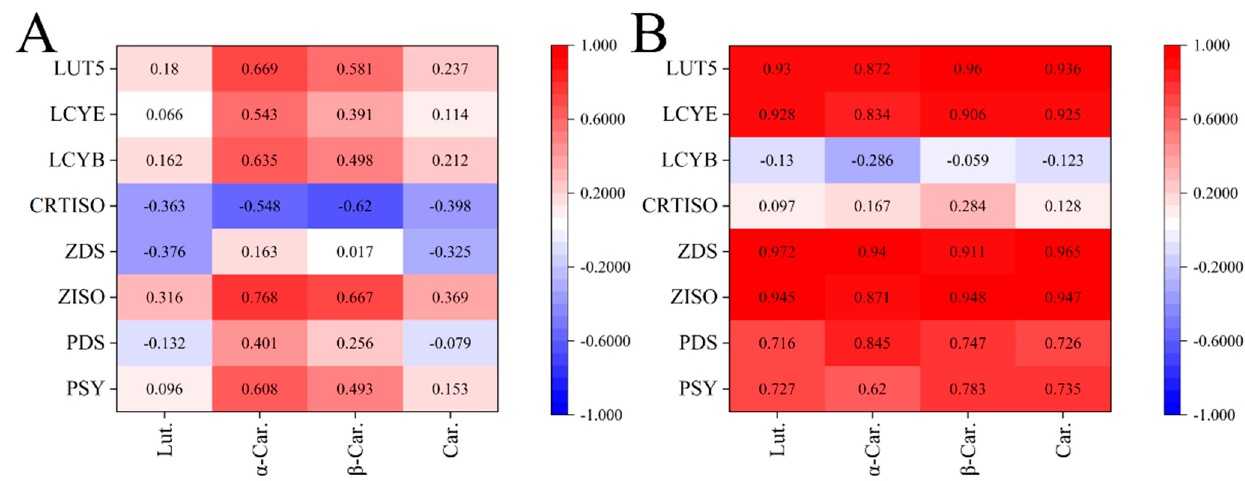
Figure 3. Carotenoid biosynthesis pathways and related gene expression levels during early fruit development. Values are showed as the means ± SD (n = 3). GGDP, geranylgeranyl diphosphate; PSY , phytoene synthetase; PDS , phytoene desaturase; Z ‐ ISO , ζ‐ carotene isomerase; ZDS , ζ‐ carotene desaturase ; CRTISO , carotenoid isomerase; LCYE , lycopene ε‐ cyclase; LUT5 , β‐ ring hydroxylase; LCYB , lycopene β‐ cyclase.